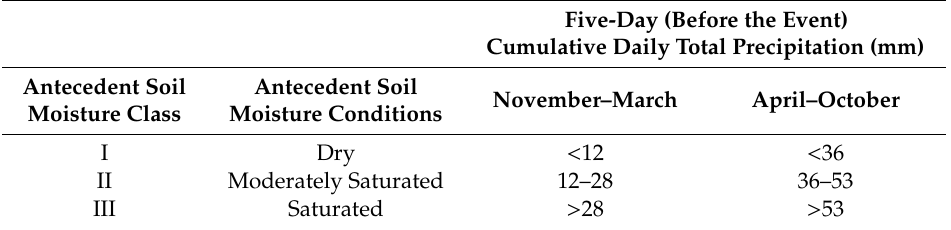
Table 2. Precipitation limits for antecedent soil moisture estimation in Turkey